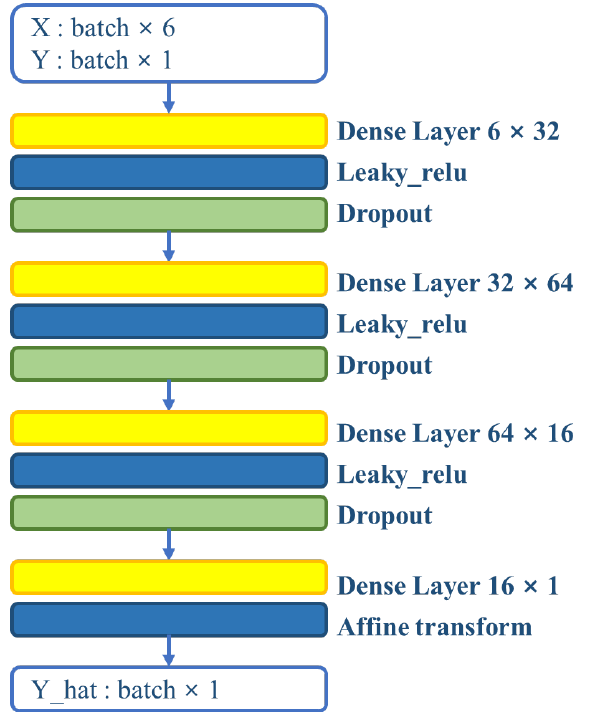
Figure 8. Neural network architecture for predicting nose temperature.